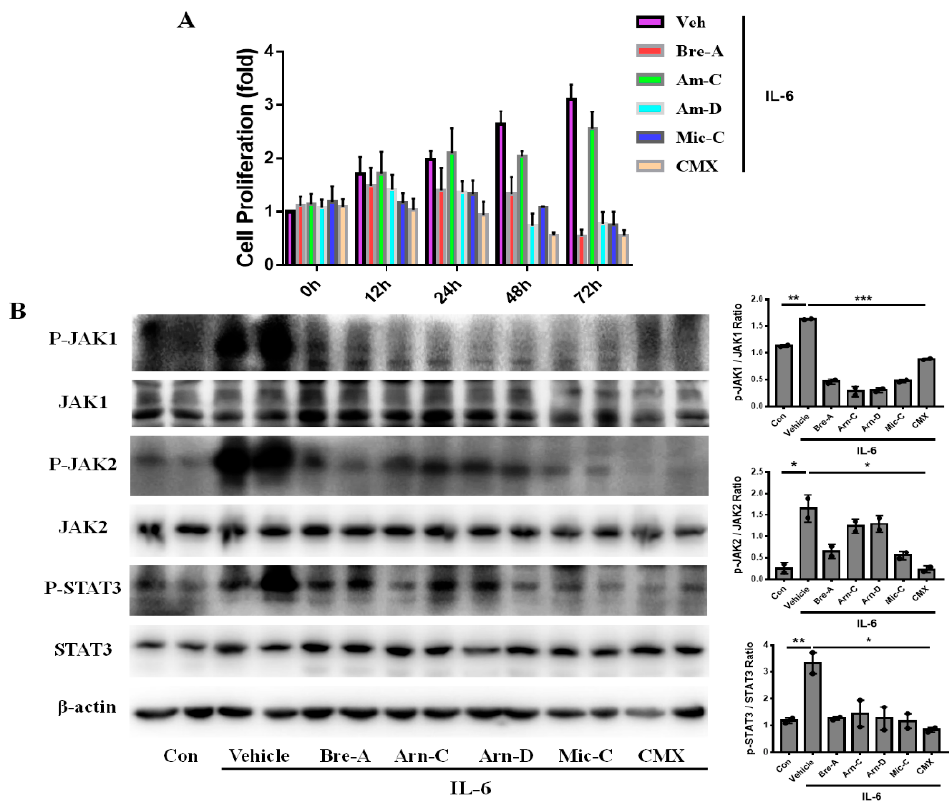
Figure 5. CMX suppresses keratinocytes proliferation through JAK1/2-STAT3 pathway induced by IL-6. ( A ) Cell proliferation was detected in HaCaT incubated by only rh-IL-6 or co-incubated with CMX for 0, 12, 24, 48, and 72 h. ( B ) Protein expression of p-JAK1, JAK1, p-JAK2, JAK2, p-STAT3, and STAT3 was evaluated by Western blot. The data were expressed as means ± sem. * p < 0.05, ** p < 0.01, *** p < 0.001. Two repeated trials were presented per group ( n = 2). All experiments were repeated 3 times. All the concentrations of mixtures or components were 3 µg/mL or 6 µg/mL. Bre-A, Brevilin A; Arn-D, Arnicolide D; Arn-C, Arnicolide C; Mic-C, Microhelenin C; CMX, emulsion extract from Centipeda minima.